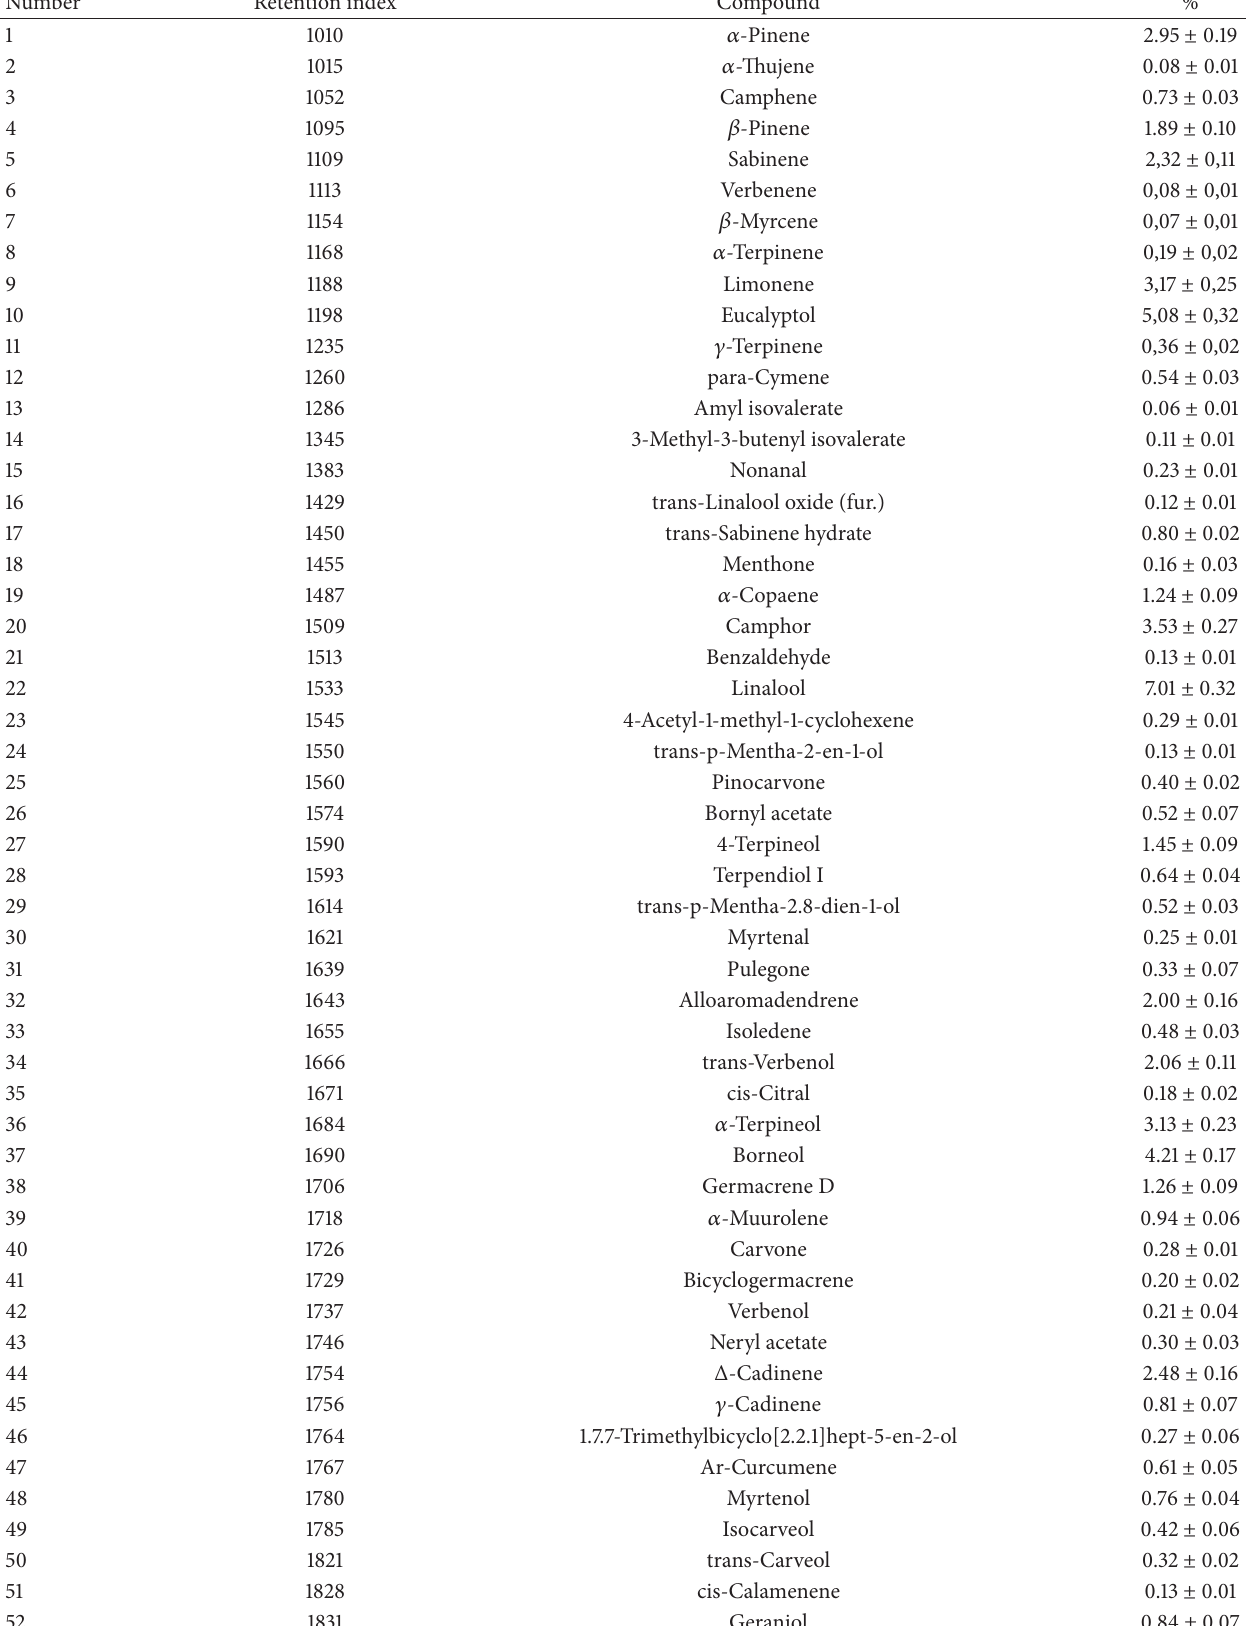
Table 3: Essential oil composition of T. cilicicum